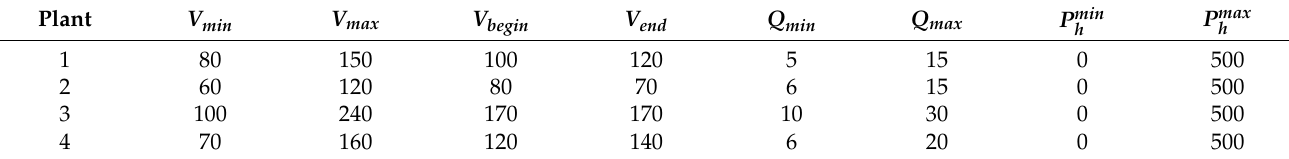
Table 8. Power station basic parameters (unit of storage capacity: 10,000 m 3 , unit of inflow rate: 10,000 m 3 , unit of output: